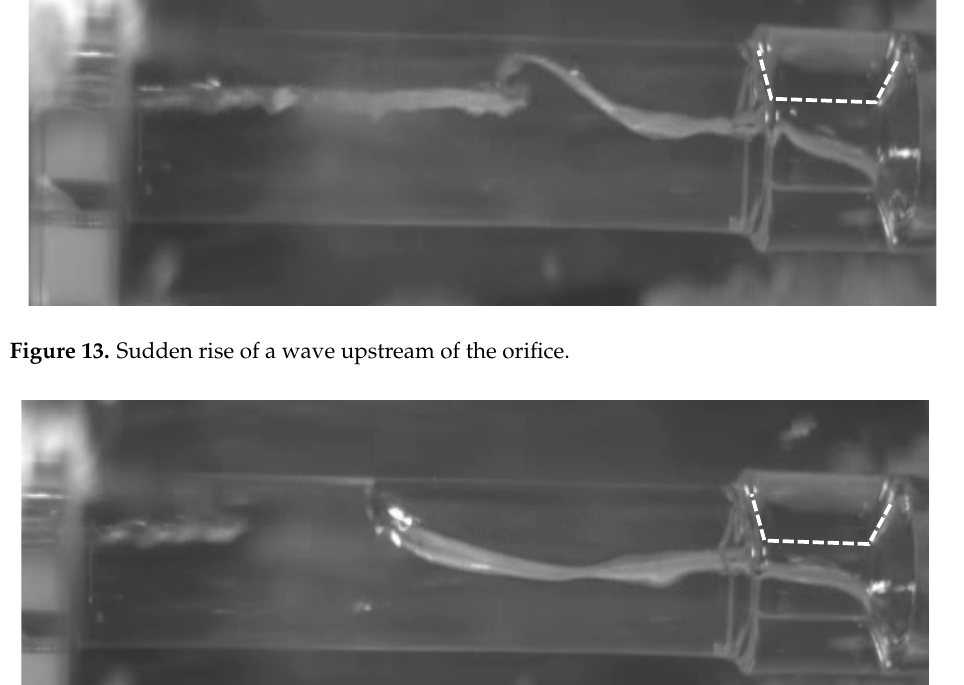
Figure 15. Smooth stratified flow upstream of the orifice. The mechanism can be explained by comparing the detailed flow pattern with the corresponding differential pressures. A cycle from 16:10:31 can be taken as an example. It shows that in a stratified flow, the differential pressure DPT is at its minimum, and the DPST is at its maximum, i.e., the pressure difference across the orifice is at its maximum levels (Figures 16 and 17a). The vapor flowrate is higher throughout the orifice, whereas the condensate drainage is lower, leading to an increase in DPT and a decrease in DPST, while DPS remians stable (Figures 16 and 17b). As the pressure difference across the ori- fice decreases, the steam flowrate decreases, and the condensate drainage increases, which causes choking (Figure 17c) at the inlet of the orifice and subsequent stratified wavy flow (Figure 17d), followed by slug flow (Figure 17e). Meanwhile, the differential pressure DPT begins to decrease (Figures 16 and 17f) until it reaches its minimum levels, at which time, the stratified flow occurs (Figure 17g). The whole cycle is then repeated.